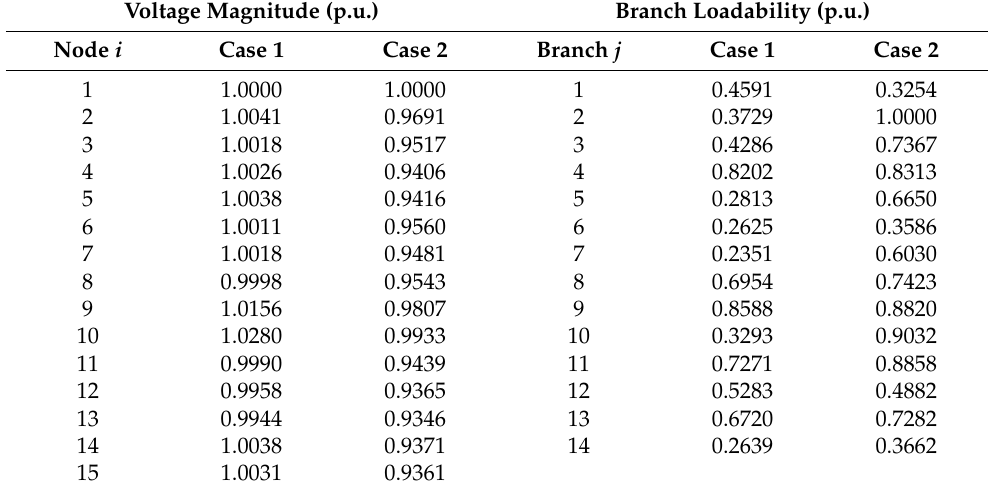
Table 6. Voltage magnitude and branch loadability after upward/downward balancing energy